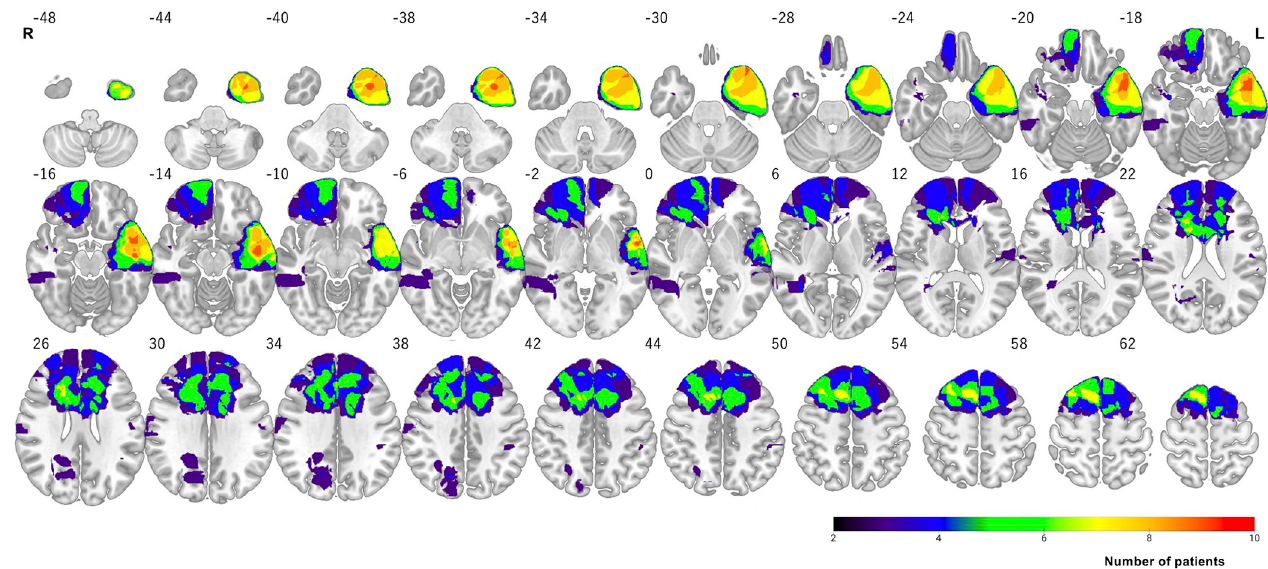
Fig 1. Overlay map of the resection cavity in patients with brain lesions. Maximum resection cavity overlaps in the left temporal lobe. Red indicates an area with a large overlap of the resection cavities. R, Right; L, Left.